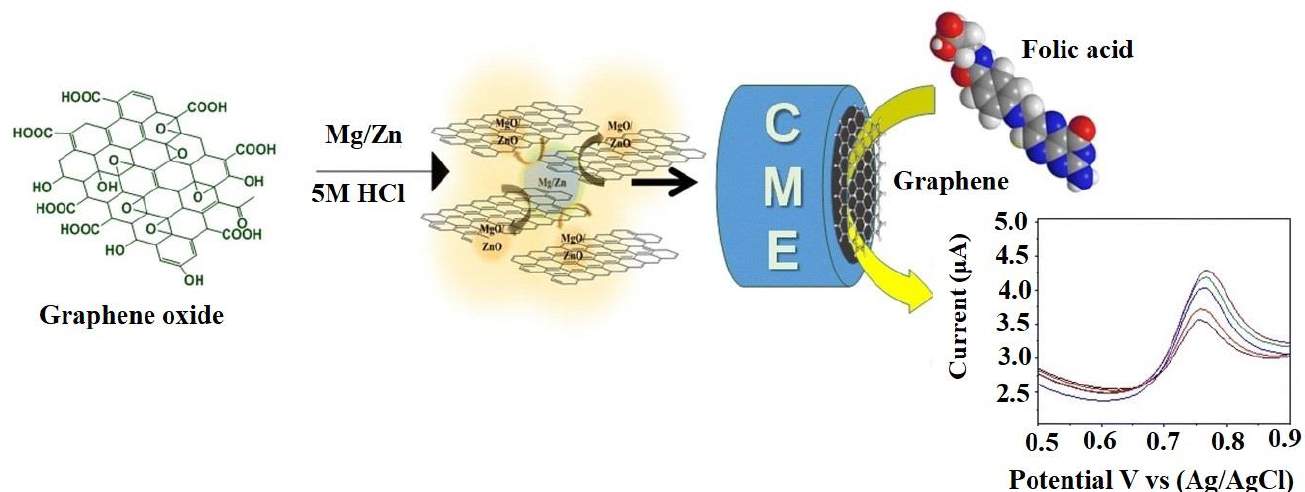
Figure 15. Graphene-based electrochemical biosensor for detection of folic acid. Reproduction re- quires permission [182]. Copyright 2016 Springer. permission from [182]. Copyright 2016